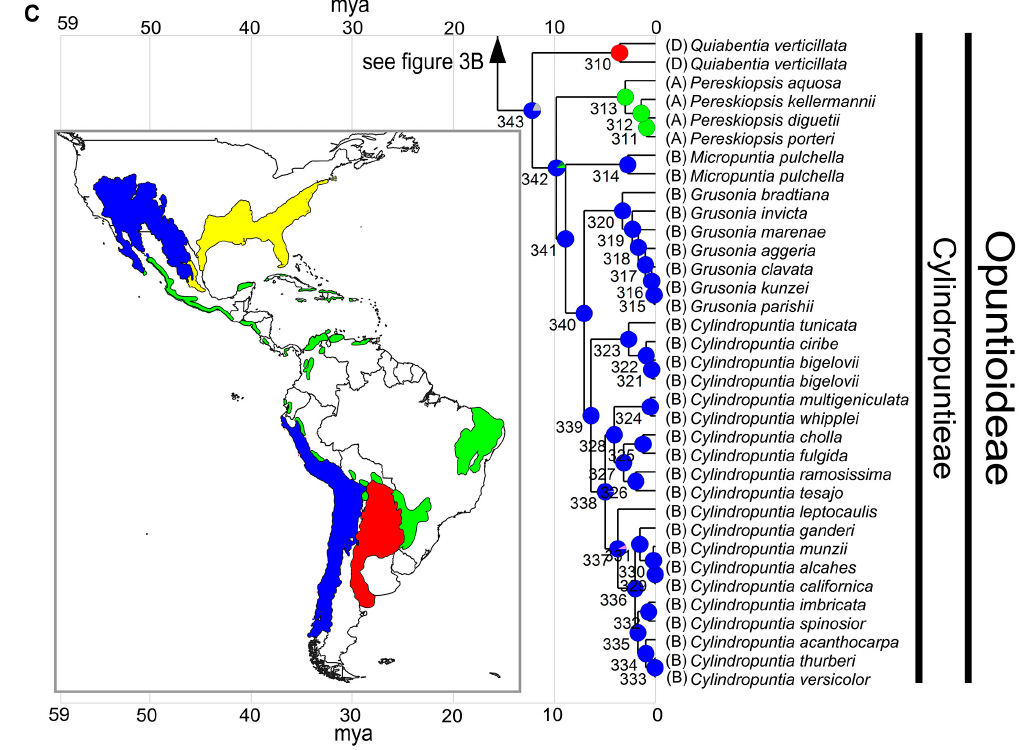
Figure 3. Ancestral habitat reconstruction using our BEAST chronogram. ( A ) Cactaceae were reconstructed as evolving in a desert environment, while the Pereskia clade originated in SDTF, Core Cactoideae I moved into SDTF from the desert, and Core Cactoideae II were reconstructed as evolving in the Chaco before moving into SDTF and back into the desert. ( B ) Opuntieae were reconstructed as evolving in SDTF and, from there, moving into the desert, Chaco and temperate forest, while Tephrocacteae were reconstructed as evolving in the desert and then moving into SDTF, and ( C ) Cylindropuntieae evolved in a desert habitat and then moved into the Chaco and SDTF.